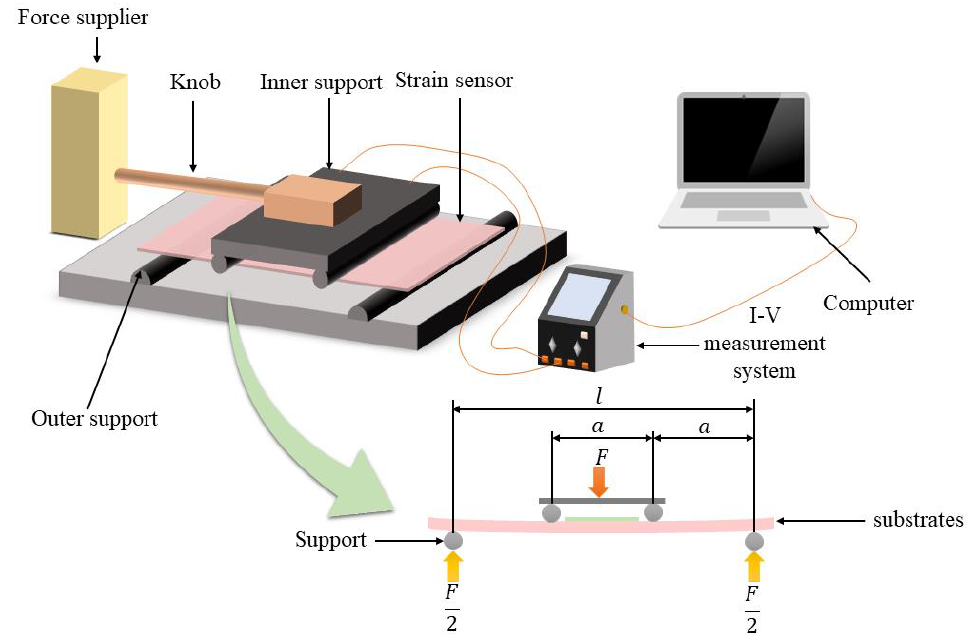
Figure 4. Schematic of the four-point bending method for testing the CB/PVA composite film strain sensor under different loads.